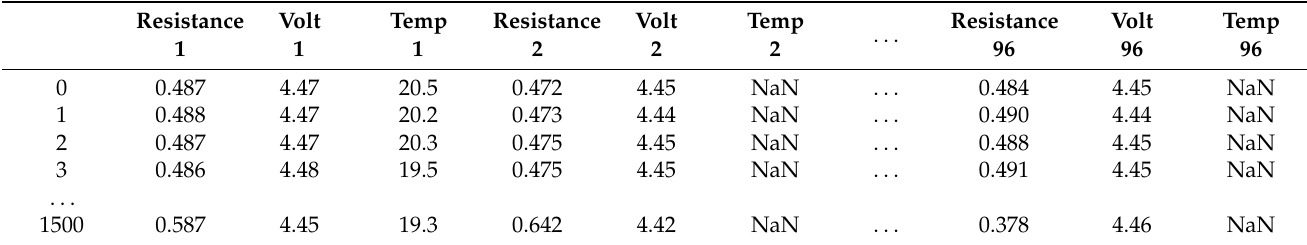
Table 4. BANK data prior to clustering.